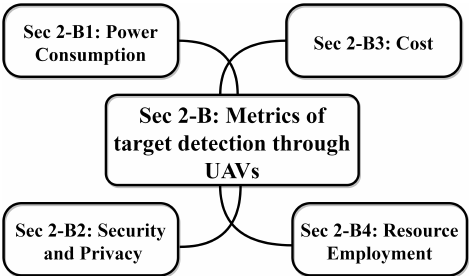
Figure 5. Metrics of target detection through